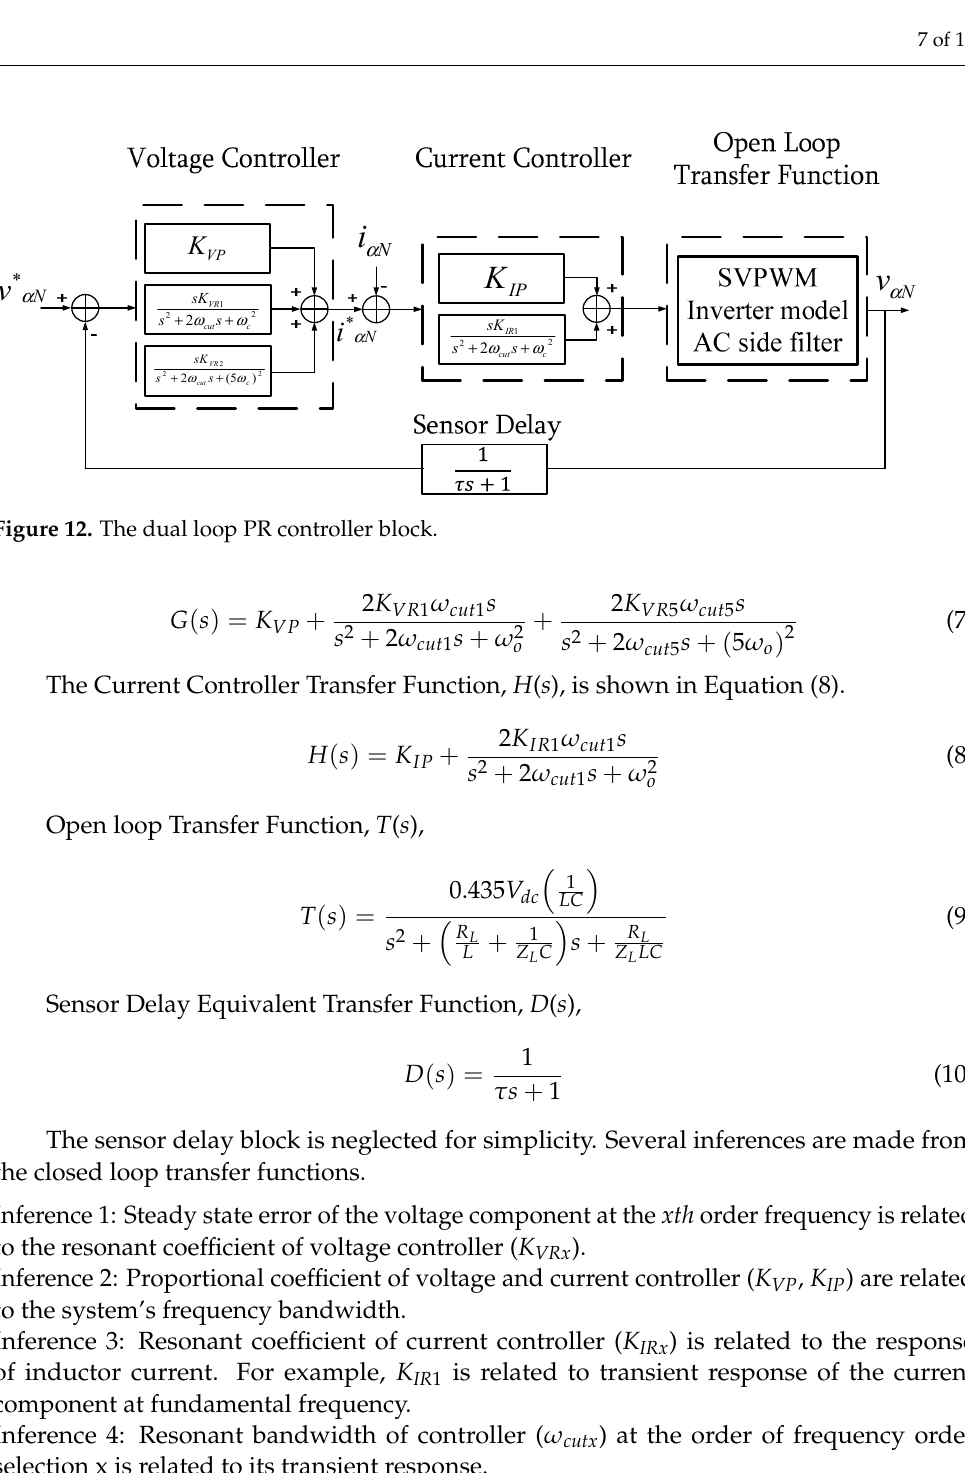
7 of 19 Figure 11. The current waveforms under the compensated nonlinear load condition.